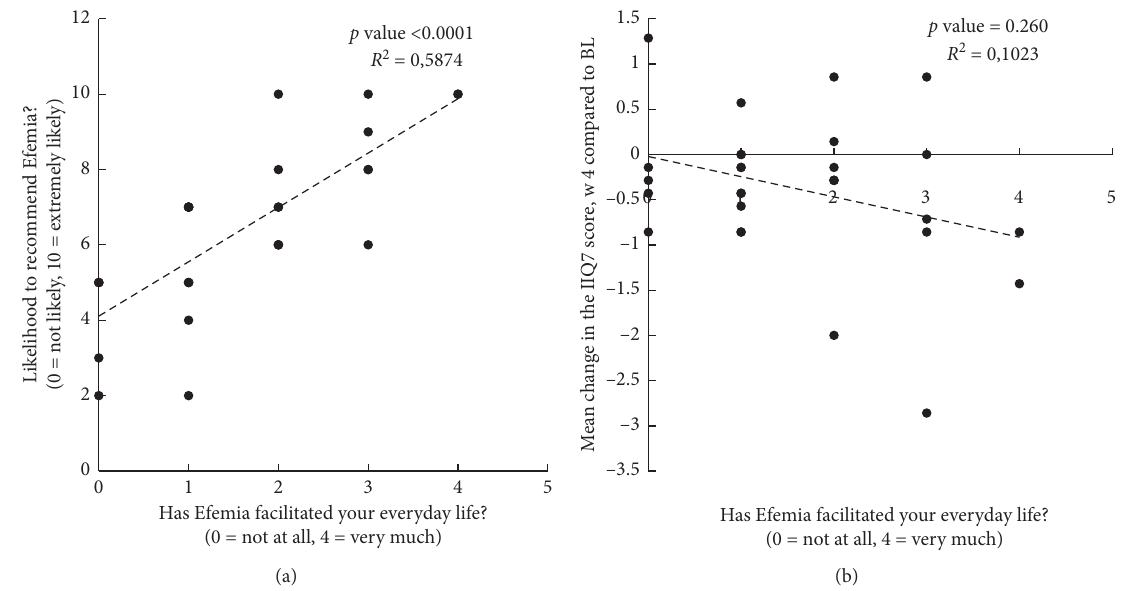
Figure 5: Likelihood to recommend (graph (a)) and mean change in the IIQ-7 score (graph (b)), plotted against facilitation of everyday life, TVS3000 ( n � 30).